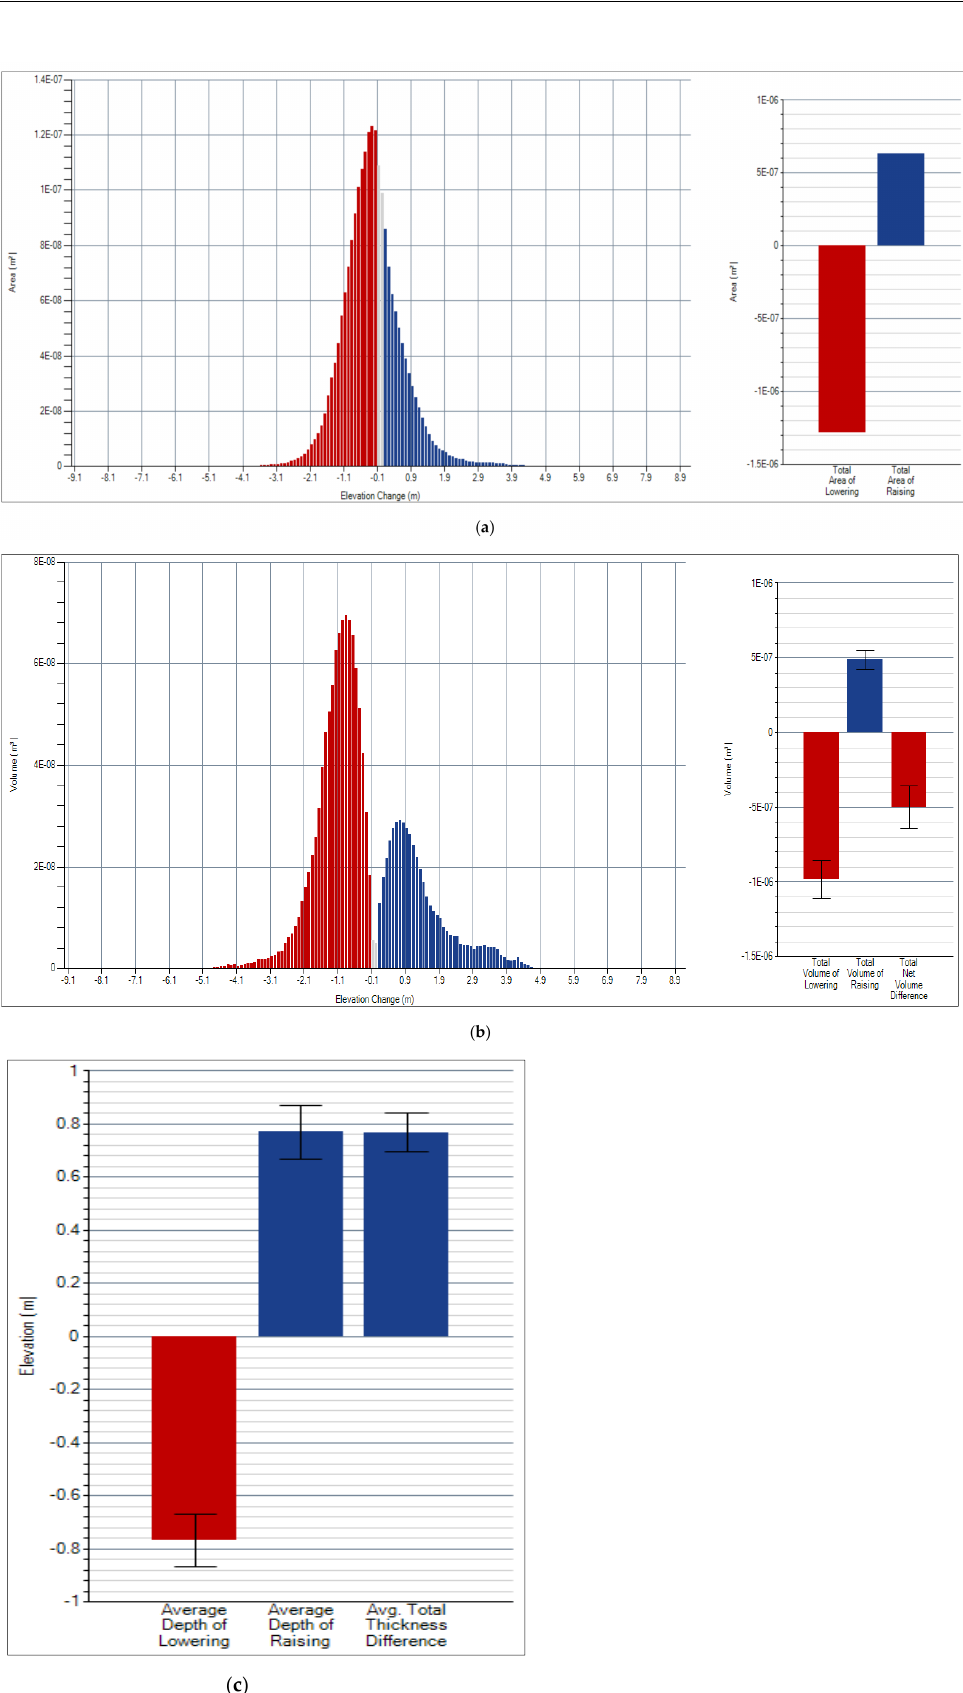
Figure A6. GCD result for ROI7.